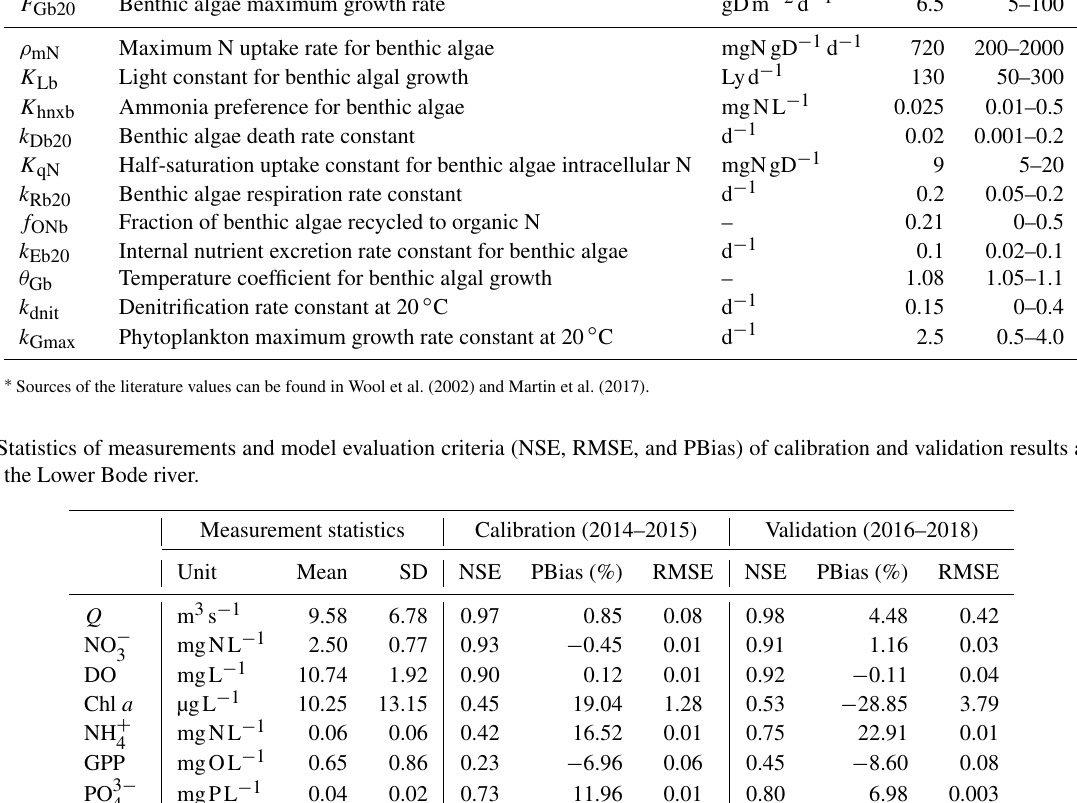
Table 2. Identifiable parameters related to DIN processing and their optimized values. Symbol